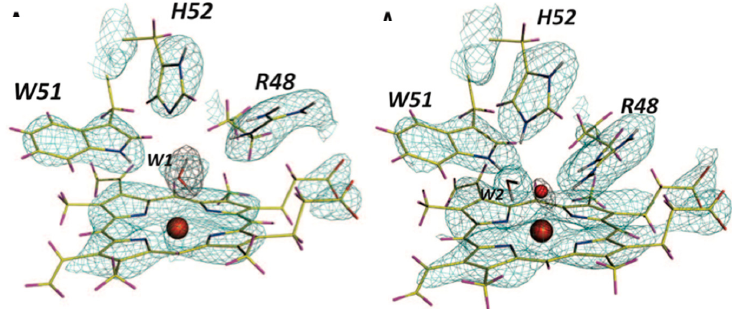
Figure 9. Neutron crystal structures of cytochrome c peroxidase in the ferric and Compound I form. ( Left ) nuclear density maps show that a heavy water, D 2 O, is bound to the heme; ( Right ) nuclear density maps show that oxygen is bound to the heme in the Compound I intermediate form. Figure reproduced from [41].